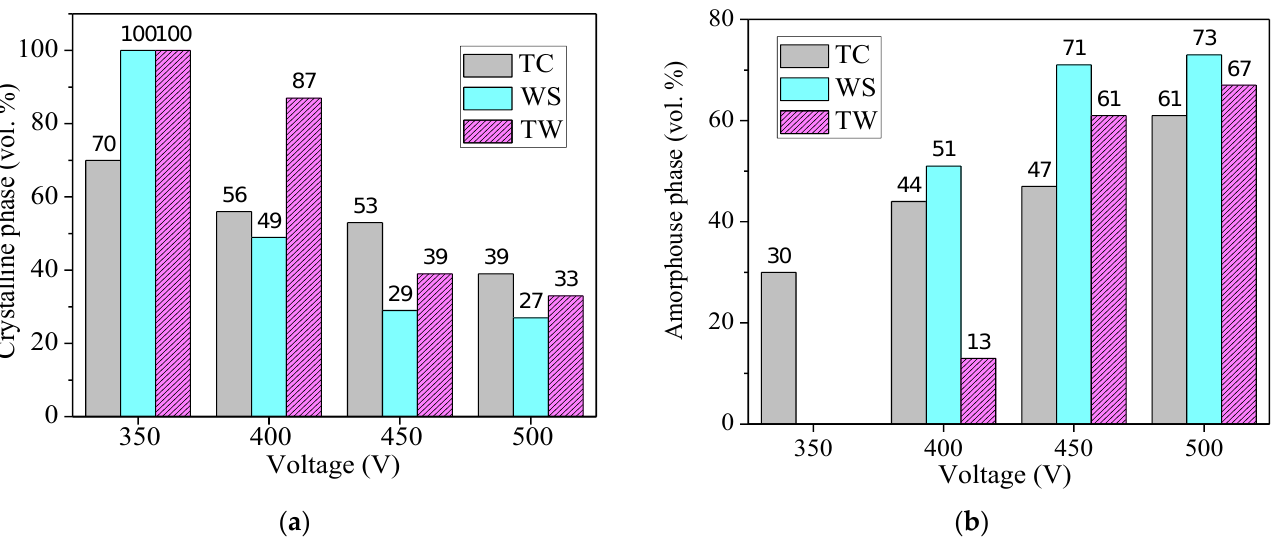
Figure 8. Diagrams of the content of crystalline ( a ) and amorphous ( b ) phases in the coatings versus the voltage of the coating’s deposition.